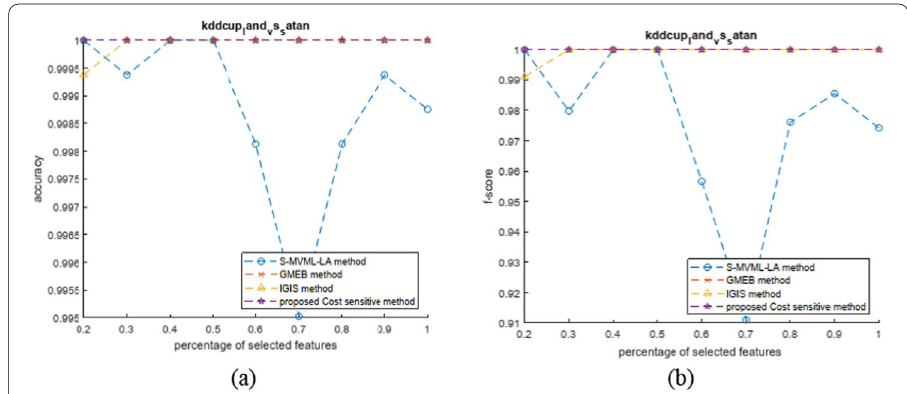
Fig. 5 The performance of the proposed cost sensitive method, S-MVML-LA [15], GMEB [10] and IGIS [20] versus the changes in percentage of selected features numbers on the kddcup_land_vs_satan dataset. a Accuracy, b f-score